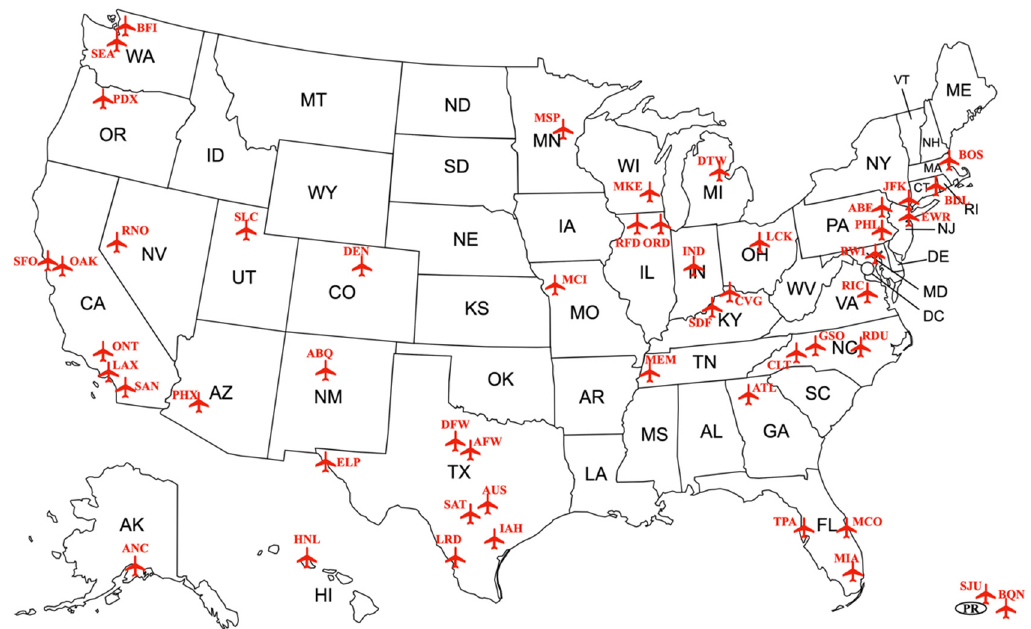
Figure 1. Location of top 50 US cargo airports analyzed in this